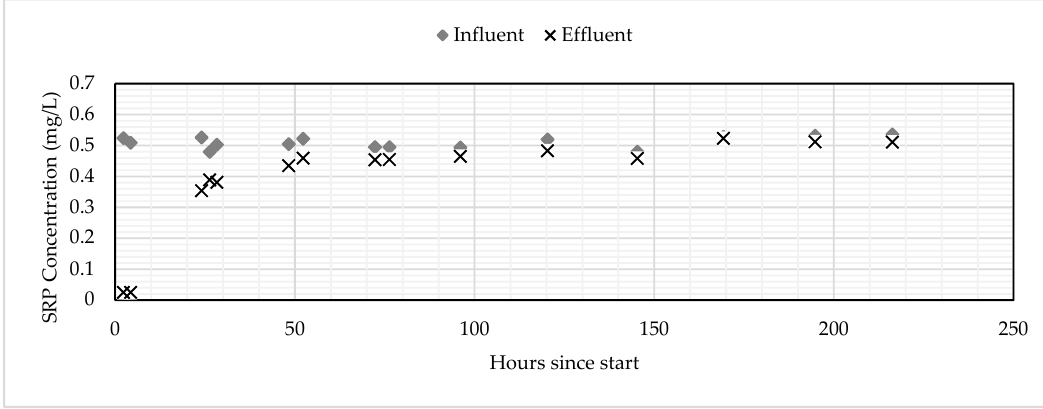
Figure 4. Influent and effluent concentrations for the SFS.